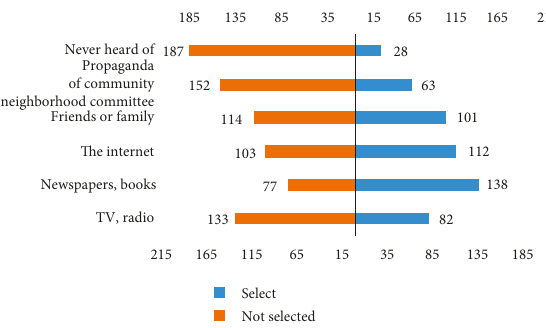
Figure 7: Respondents’ understanding of the publicity of garbage classification.